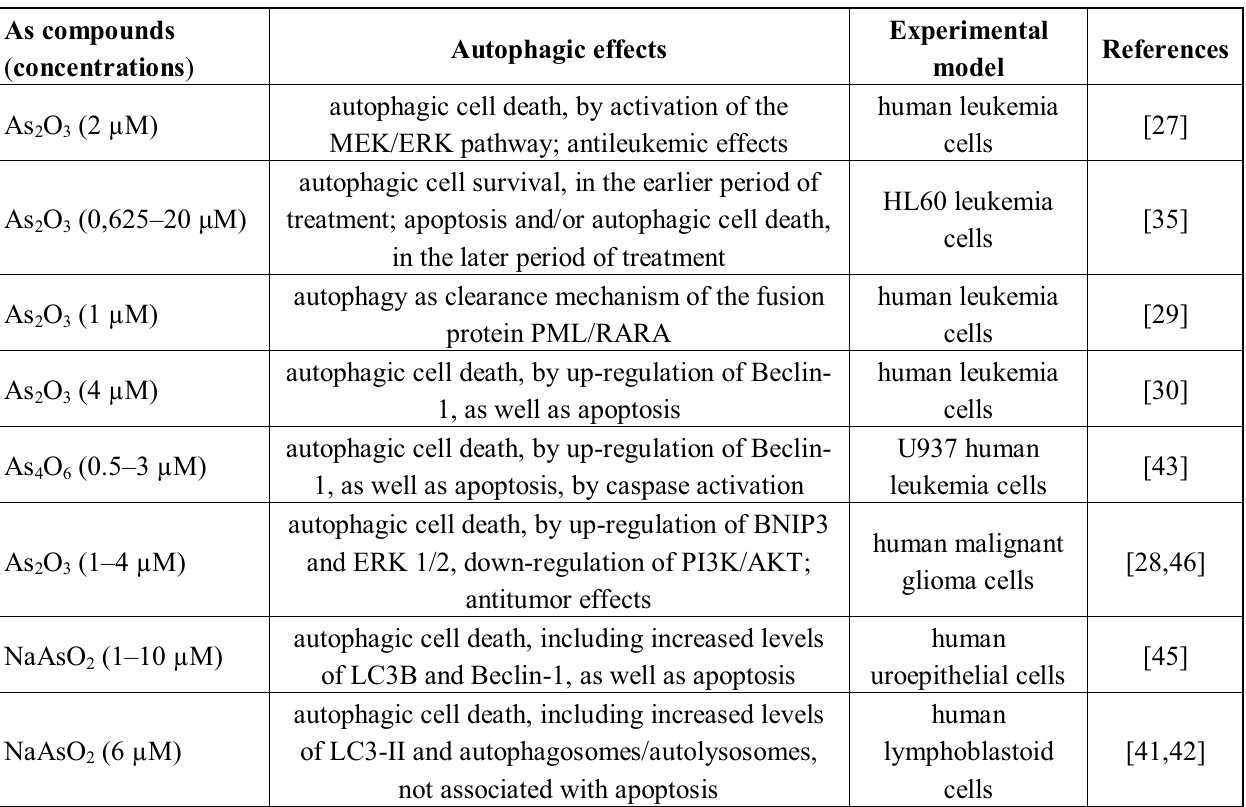
Table 1. Arsenic concentration and induced cellular response with respect to autophagy. As